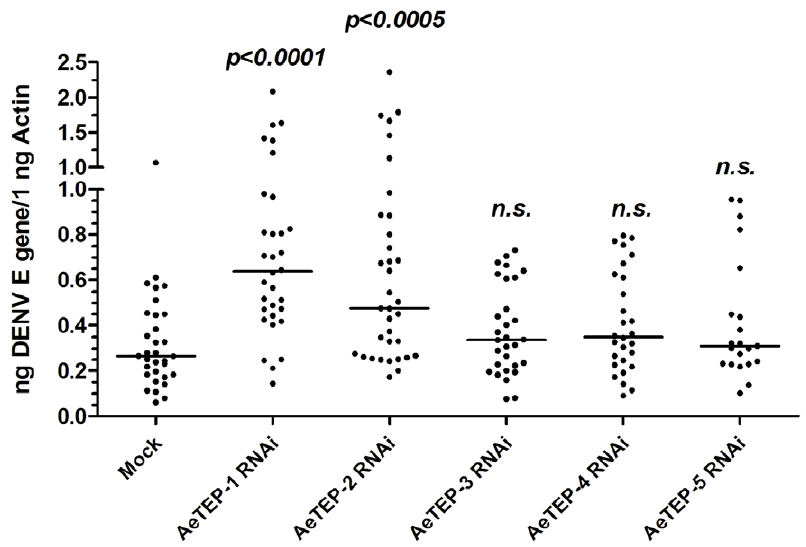
Figure 3. Silencing AeTEPs enhances DENV infection. AeTEPs were silenced by dsRNA treatment. The mock group was treated with the same amount of GFP dsRNA. The DENV burden was examined at 6 days post-infection. 10 MID 50 DENV was used to challenge mosquitoes. The viral load was determined by Taqman H QPCR, and normalized by Ae. aegypti actin . Each dot represents 1 mosquito. The Mann-Whitney test was used for statistic analysis. The horizontal lines depict the medians of result. The result shown was combined with 3 independent experiments. Drosophila S2 cells. Immunoblot confirmed the expression of a , 200 kD recombinant protein encoded by the AeTEP-1 (Figure 4a) and , 100 kD proteins by AeTEP-3 and truncated AeTEP-1-BstBI genes (Figure S4a). Subsequently, these recombi- nant plasmids were microinjected into mosquitoes with Cellfectin II H to assess the efficiency of in vivo over-expression. The same amount of empty pAc vector or pAc- Ae TEP plasmids alone served